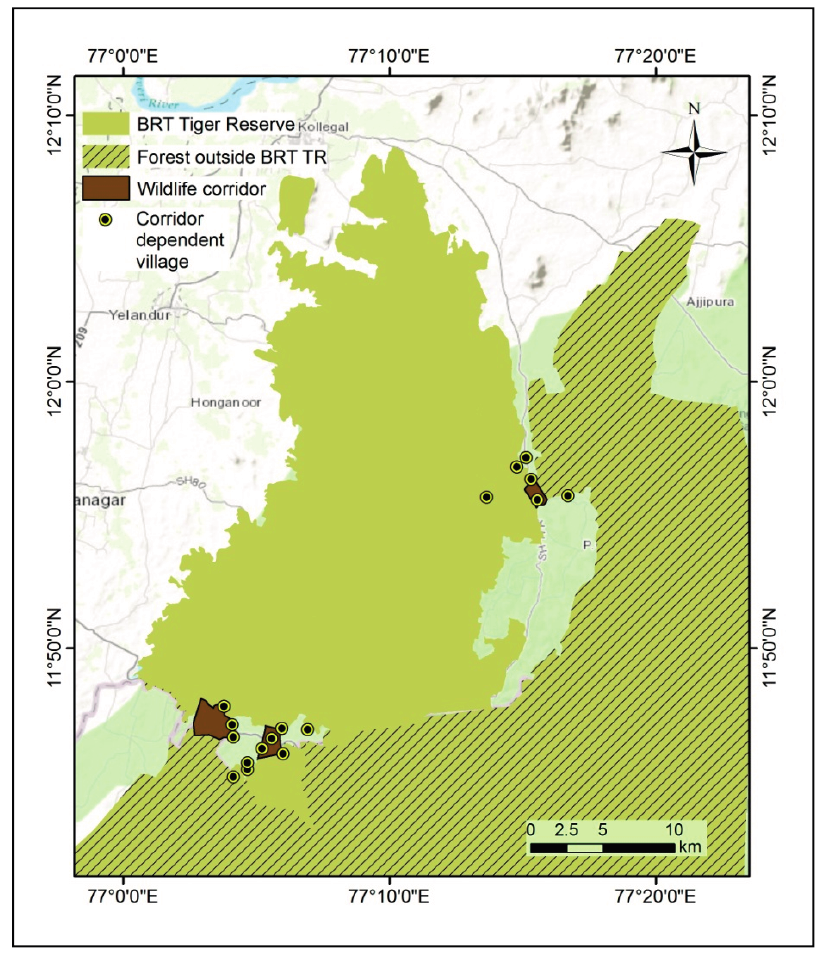
Figure 2. Matrix of forests, wildlife corridors, dependent villages, farmland and road network in Biligiri Rangaswamy Temple Tiger Reserve